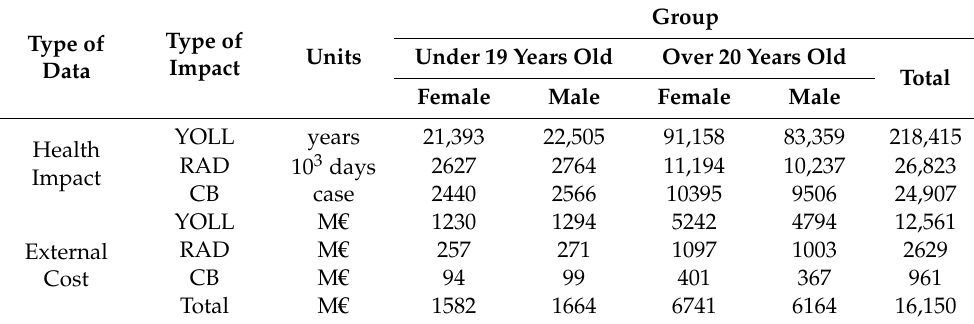
Table 3. The heath impact (YOLL—years of life lost; RAD—restricted activity days; and CB—chronic bronchitis) and external cost for each impact type in Poland associated with PM2.5 in 2015.